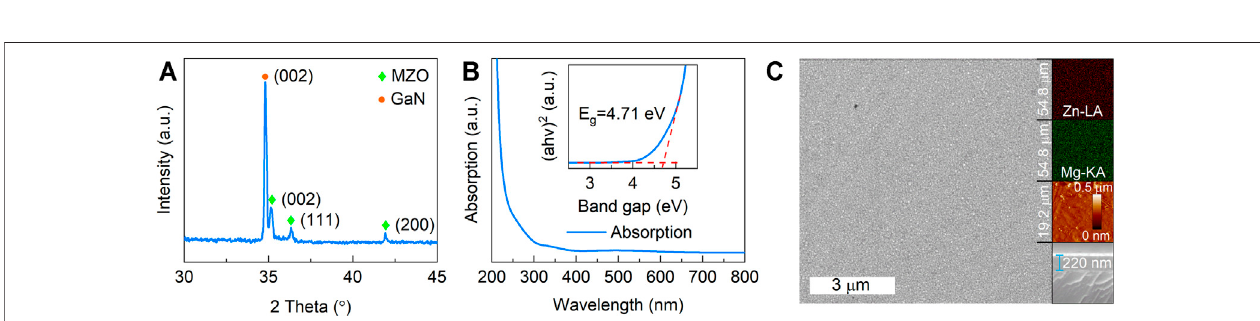
FIGURE2| Characterization ofMZO fi lm. (A) XRD result ofMZO fi lm, which showsthat the fi lm ismainly hexagonal phase. (B) The absorption spectrum and band gap diagramoftheMZO fi lm,withacut-offedgeof263 nmand abandgapof4.71 eV. (C) Thesurfacemorphology,element distribution and thickness ofMZO fi lm.the element of Mg and Zn is evenly distributed, the surface of MZO fi lm is smooth and its thickness is 220 nm.